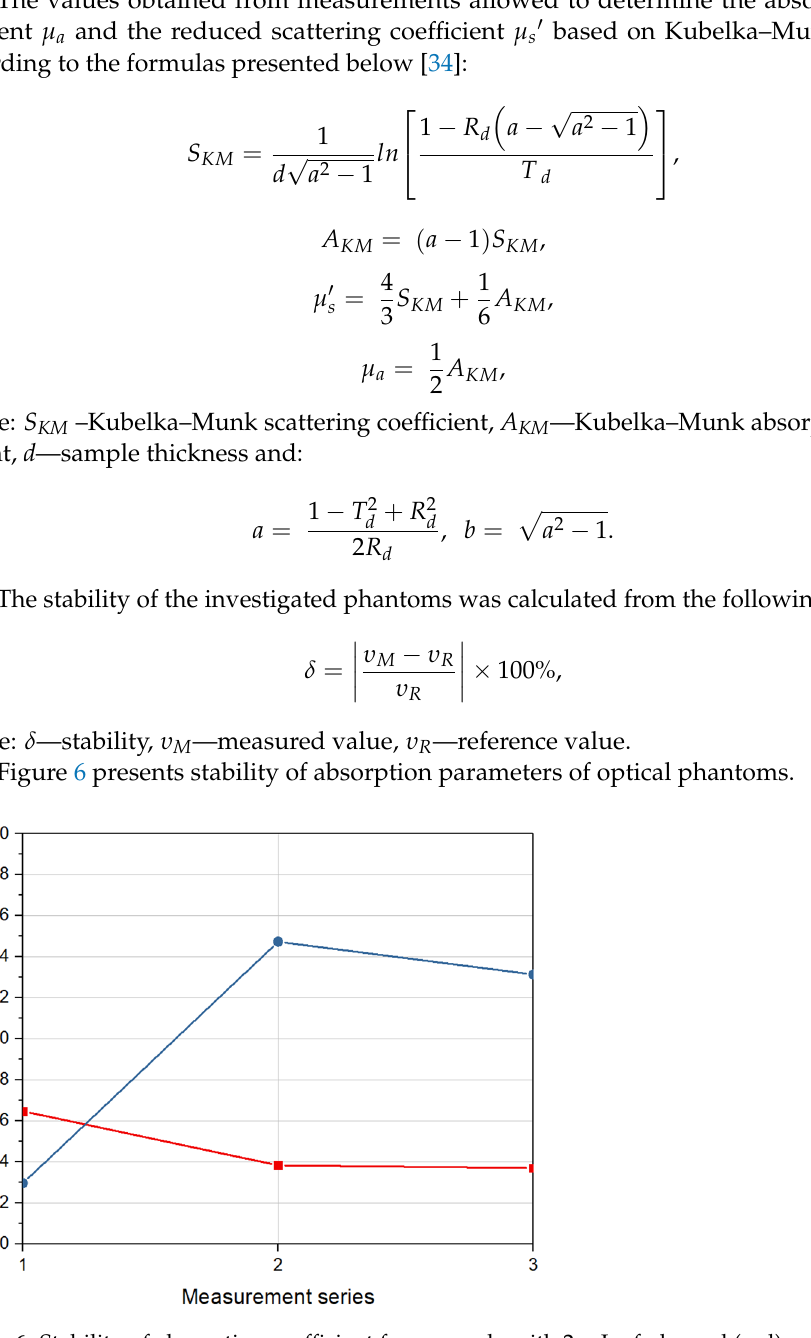
Figure 6. Stability of absorption coefficient for a sample with 2 mL of glycerol (red) and a sample with 5 mL of glycerol (blue) over time, in relation to reference measurement. Each measurement series represents the stability of absorption coefficients of investi- gated optical phantoms in relation to reference data. As shown in Figure 6, the stability of phantoms with 5 mL of glycerol are almost 1.5 times bigger than the stability of phantoms with 2 mL of glycerol. The maximum calculated stability of absorption coefficients for both samples equals